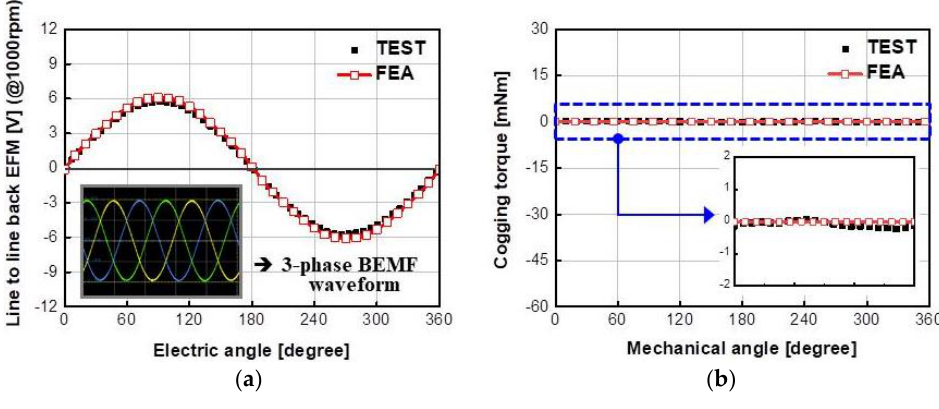
Figure 19. Testing result: ( a ) back EMF, and ( b ) Cogging torque.